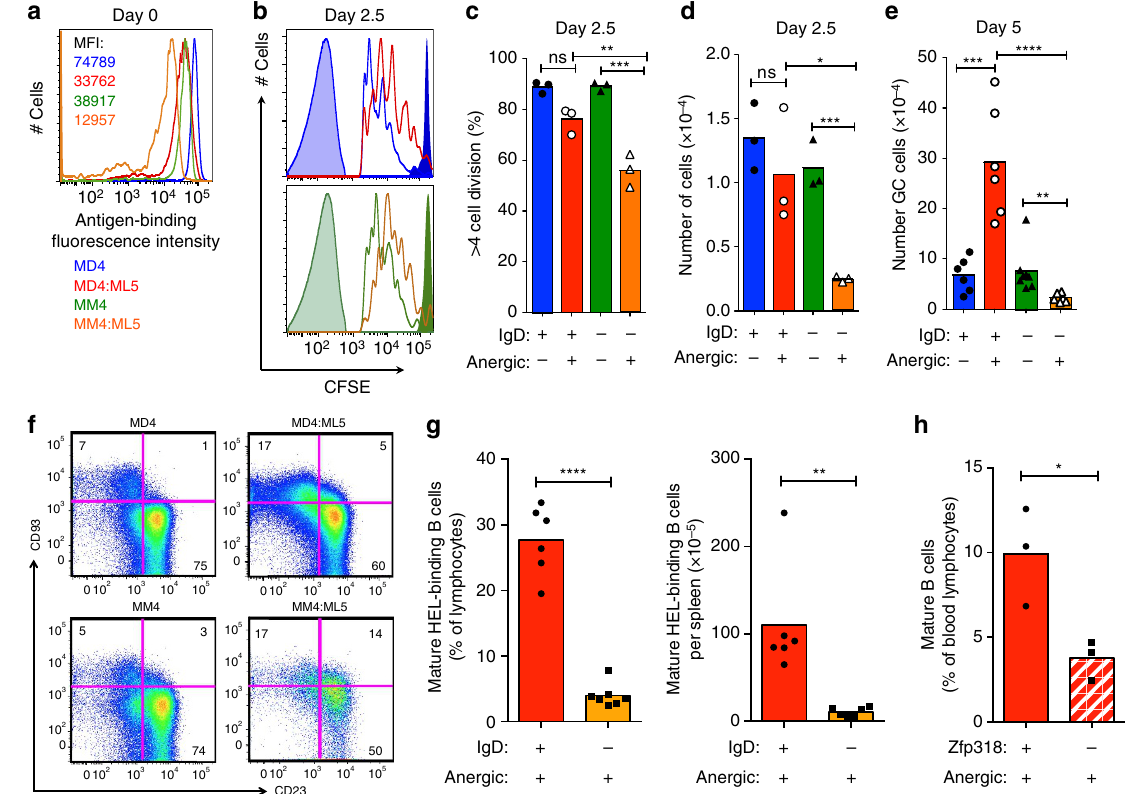
Figure 2 | IgD promotes accumulation of mature anergic B cells and germinal centre cell progeny. ( a – e ) Adoptive transfer of equal numbers of CFSE- loaded CD45.1 þ spleen B cells, either naive B cells from MD4 transgenic mice co-expressing IgM HEL and IgD HEL (blue) or MM4 transgenic mice expressing only IgM HEL (green) or anergic B cells from MD4:ML5 (red) or MM4:ML5 (orange) double-transgenic mice. Schematic of experimental strategy shown in Supplementary Fig. 2. Symbols show individual recipients and columns arithmetic means. ( a ) Relative number of HEL-binding antigen receptors per donor B cell before transfer, expressed as geometric mean fluorescence intensity (MFI, arbitrary units). ( b ) CFSE fluorescence histograms 2.5 days after transfer and immunization, using gating strategy in Supplementary Fig. 3. Unshaded histograms show B220 þ CD45.1 þ HEL-binding donor B cells in the spleen, colour coded as in ( a ). To provide a reference for undiluted CFSE, dark shaded histograms are B220-negative CD45.1 þ lymphocytes in recipients of MD4 or MM4 cells. A reference for CFSE-negative cells is provided by the lightly shaded histograms from B220 þ CD45.1 (cid:2) recipient B cells. ( c ) Percentage of donor B cells on day 2.5 with CFSE diluted to less than 1/16th of undivided donor cells. ( d ) Number of donor B cells in the spleen on day 2.5. ( e ) Number of Fas þ CD38 (cid:2) CD45.1 þ B220 þ HEL-binding GC B cells in the spleen 5 days after transfer and immunization, using the gating strategy in Supplementary Figs 4–6. There was no significant difference between the four groups in total GC B cells (CD45.1 þ and CD45.1 (cid:2) ) as a % of B220 þ cells ( P ¼ 0.17; Supplementary Fig. 7). Statistical analysis by ANOVA with Bonferroni’s Multiple Comparison post-test: ns ¼ not significant, * P o 0.05, ** P o 0.01, *** P o 0.001. Representative of two independent experiments. ( f – h ) Accumulation of mature anergic B cells with or without IgD in unimmunized double transgenic mice. ( f ) Representative analyses of HEL-binding B220 þ spleen cells, gated as shown in Supplementary Fig. 8, showing percentage of B cells in indicated gates. ( g , h ) Percentage of all lymphocytes that are CD93 (cid:2) CD23 þ HEL-binding B220 þ anergic B cells in the spleen of individual MD4:ML5 and MM4:ML5 double transgenic mice ( g ) or in the blood of MD4:ML5 double transgenic mice with homozygous null or wild-type Zfp318 ( h ). Statistical analysis by t -test, representative of two independent